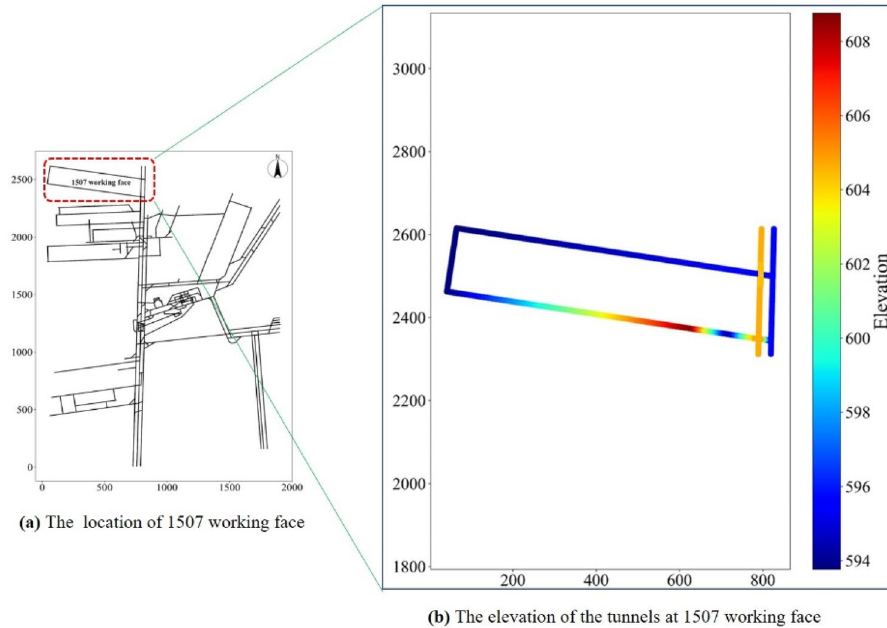
Figure 12. The 1507 working face in the Beiyangzhuang Mine.